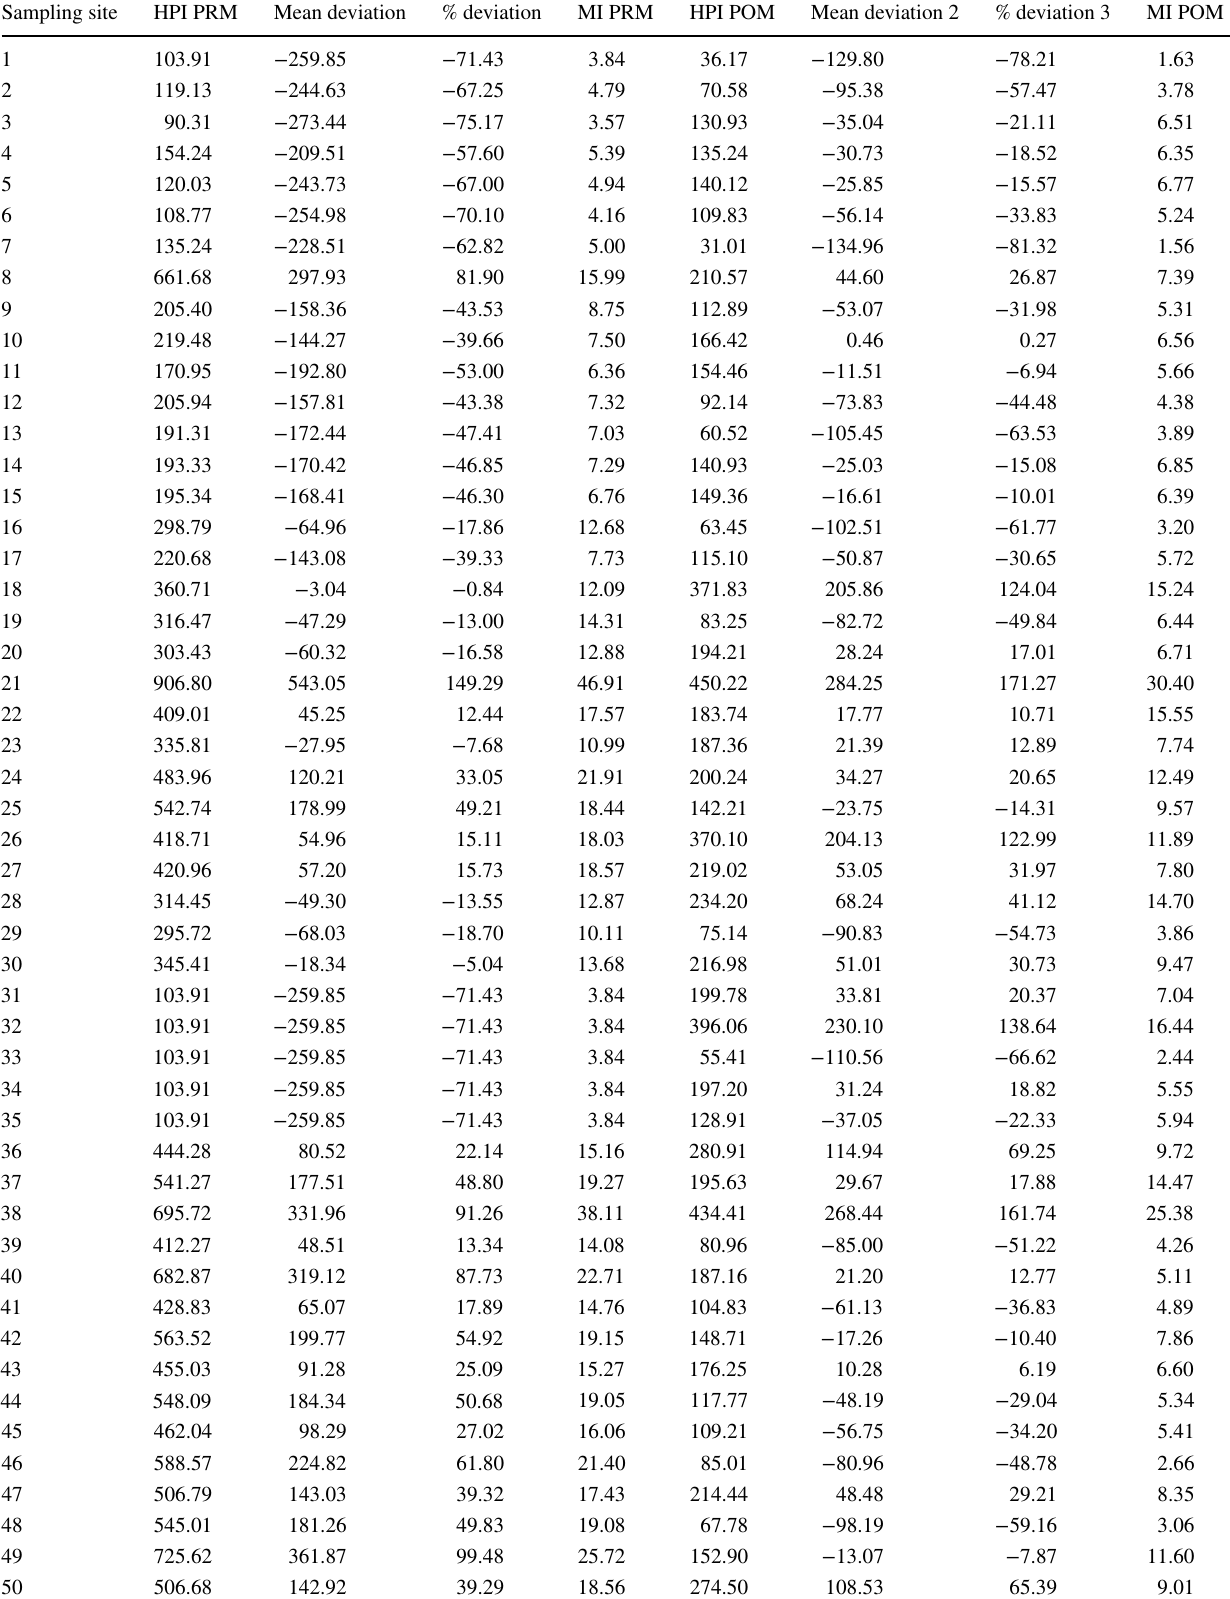
Table 4 Heavy metal pollution index and metal index in the north Chennai groundwater region during pre-monsoon and post-monsoon seasons Sampling